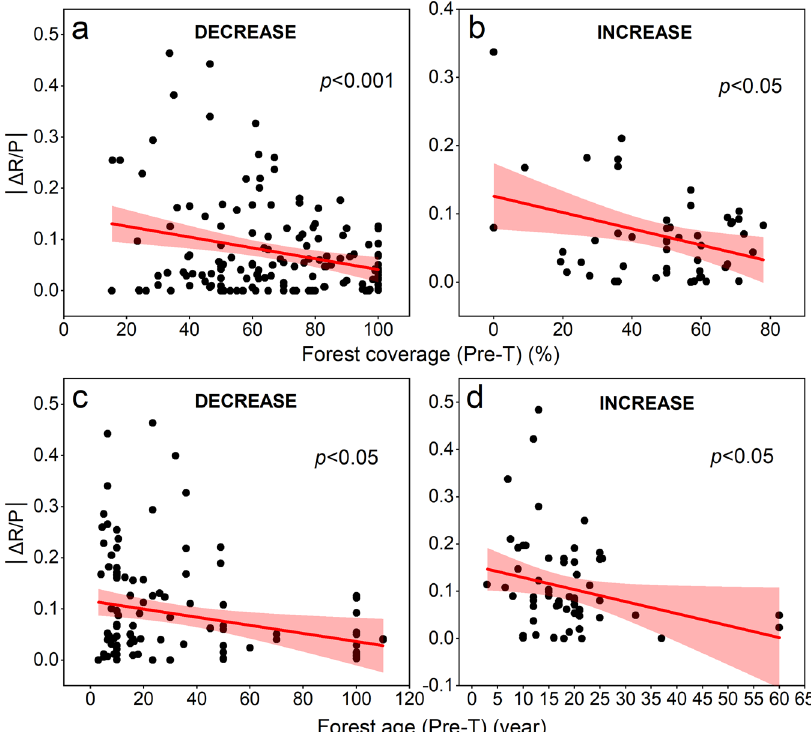
Fig. 2 Absolute values of net change of runoff coef fi cient ( │ Δ R / P │ ) in fl uenced by forest coverage and age before treatment events. a │ Δ R / P │ with forest coverage in DECREASE treatment; b │ Δ R / P │ with forest coverage in INCREASE treatment; c │ Δ R / P │ with forest age in DECREASE treatment; d │ Δ R / P │ with forest age in INCREASE treatment. Shaded area represents 95% con fi dence interval. DECREASE: felling and thinning treatments directly reduce tree numbers; INCREASE: afforestation and reforestation treatments that favors increasing the number of trees.